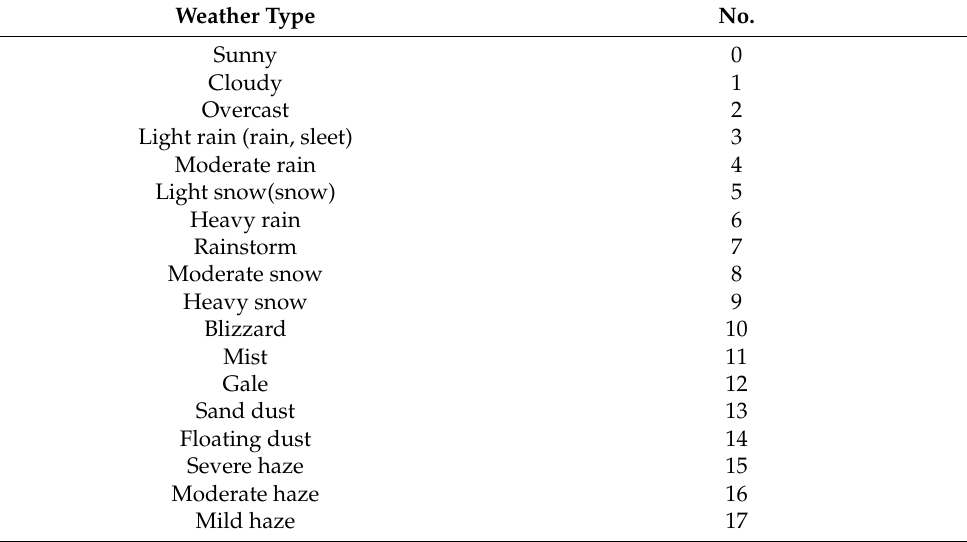
Table 3. Statistical table of the number of weather types.